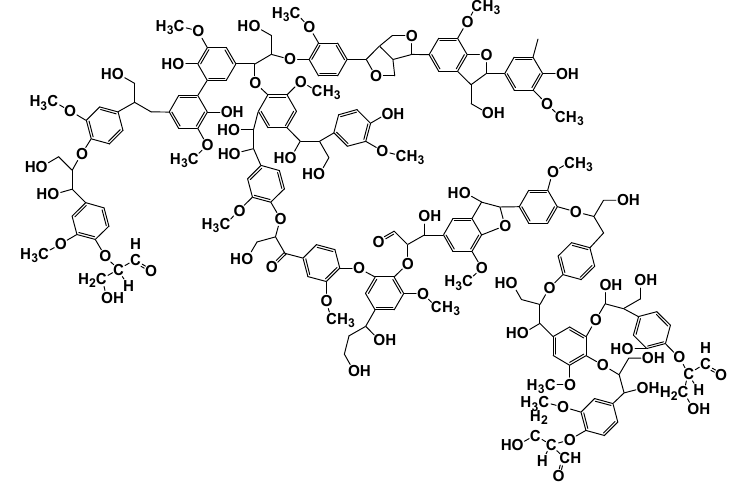
Scheme 1. Representative chemical structure of lignin.